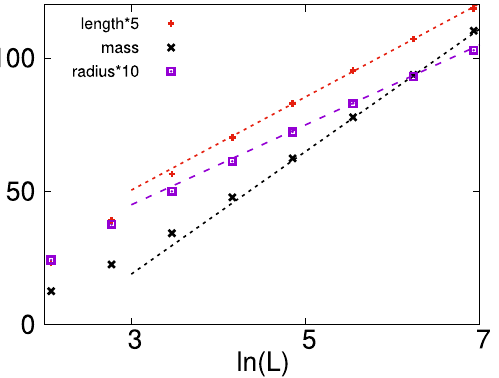
Figure 7. Average parameters of energy clusters in the d = 2 diluted TIM with site-percolation at δ = − 0.2 , having p = 0.392746 as a function of the logarithm of the size of the system: the linear extension [ ℓ ] av with asymptotic slope (cid:31) ≈ 3.5 ; the mass [ µ ] av with asymptotic slope σ ≈ 23. and the radius of gyration [ R g ] av with asymptotic slope ρ ≈ 1.5 .